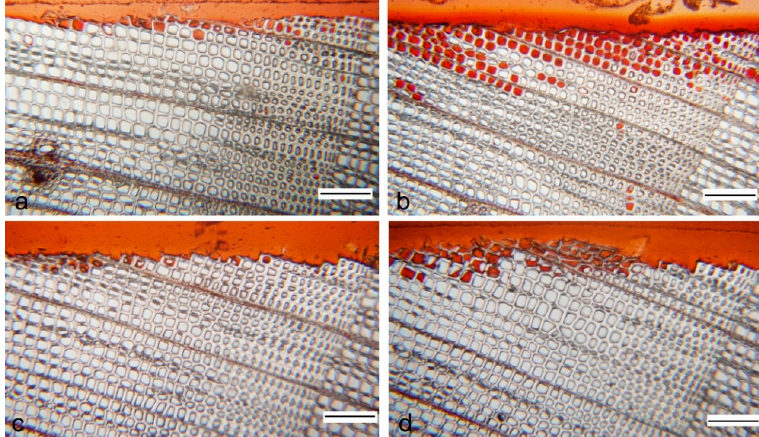
Figure 3. Light microscopy photographs of the wood coating interface in untreated and plasma-modified (1200 s) black spruce samples coated with either water- or solvent-borne polyurethane coatings: ( a ) Untreated control coated with solvent-borne polyurethane; ( b ) sample treated with plasma for 1200 s and coated with solvent-borne polyurethane; ( c ) untreated control coated with water-borne polyurethane; and ( d ) sample treated with plasma for 1200 s and coated with water-borne polyurethane. Scale bars = 100 µm.